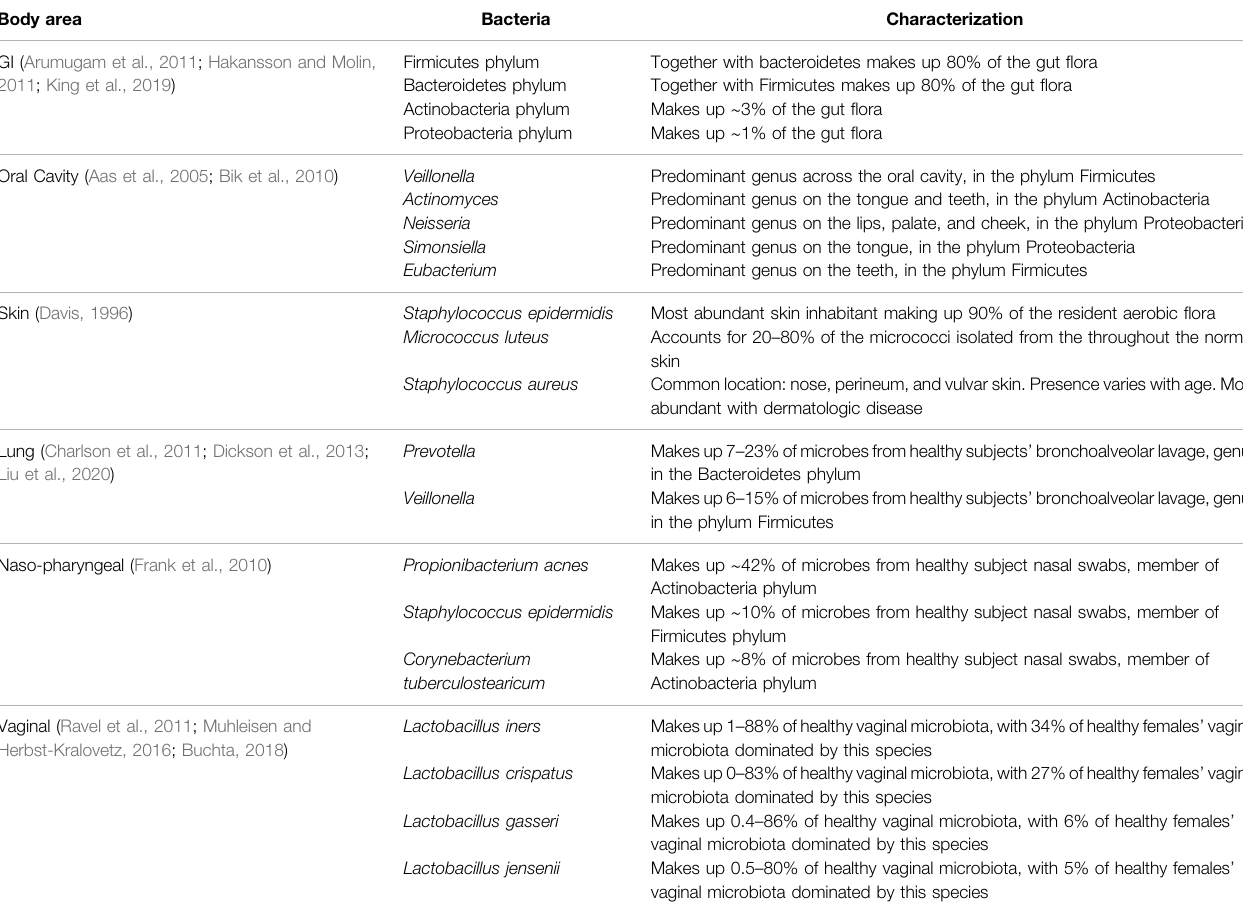
TABLE 1 | Dominant bacteria in microbial communities across the human body. Body area